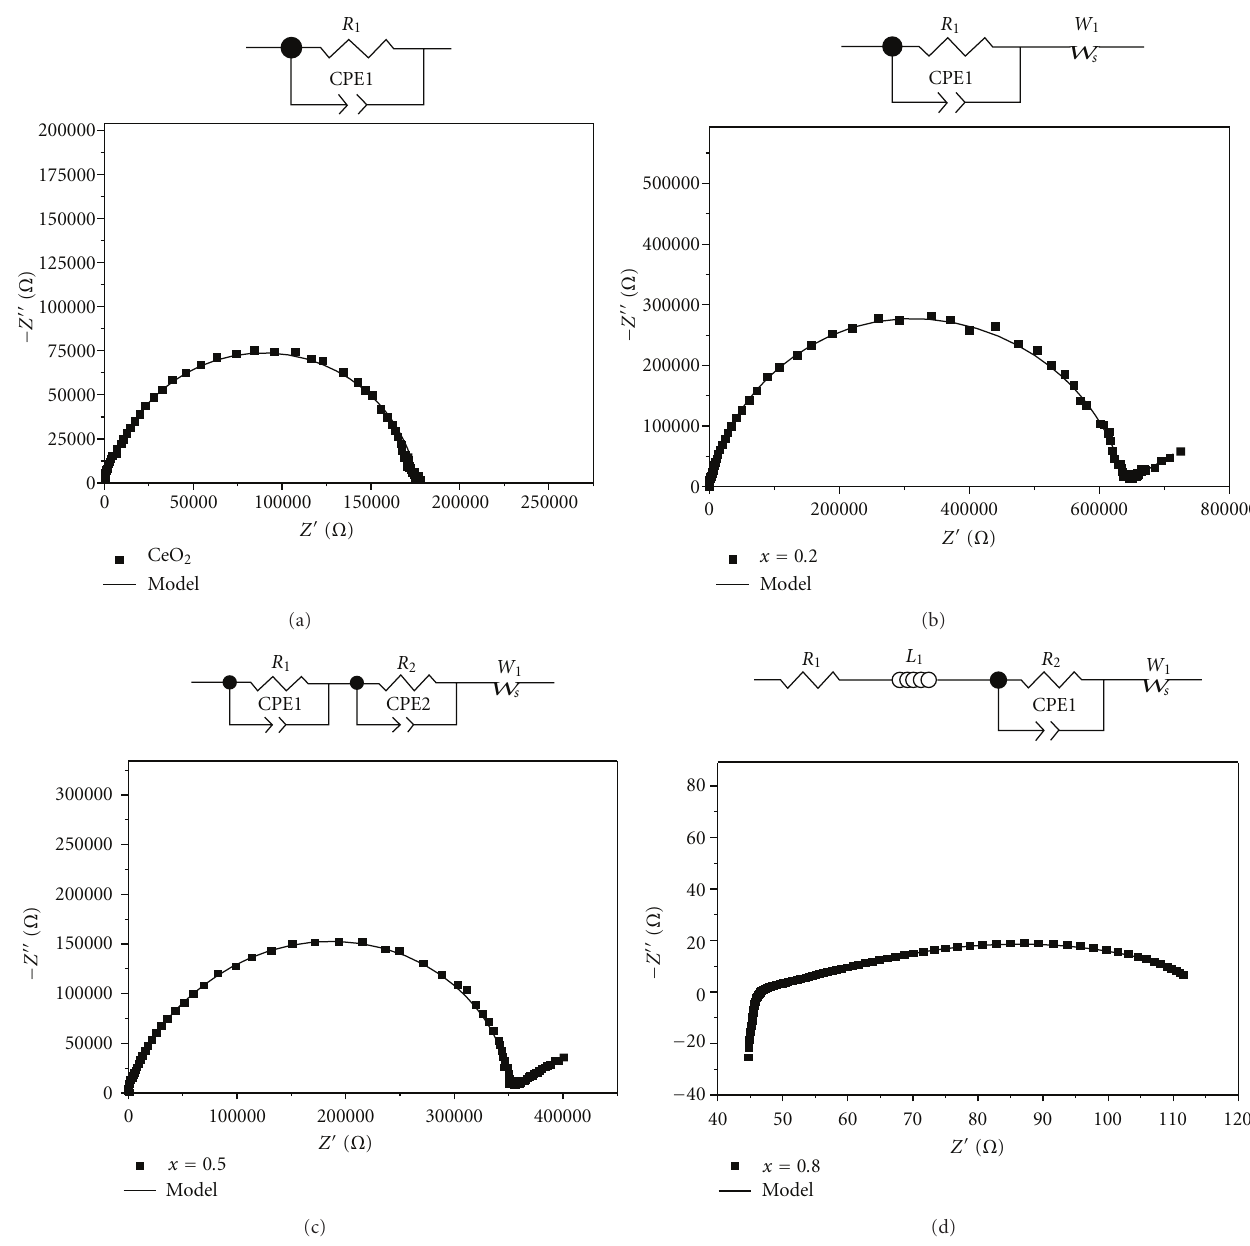
Figure 5: Comparison between calculated and experimental Nyquist representations. (a): Sample x = 0; (b): sample x = 0 . 2; (c): x = 0 . 5; (d): x = 0 .